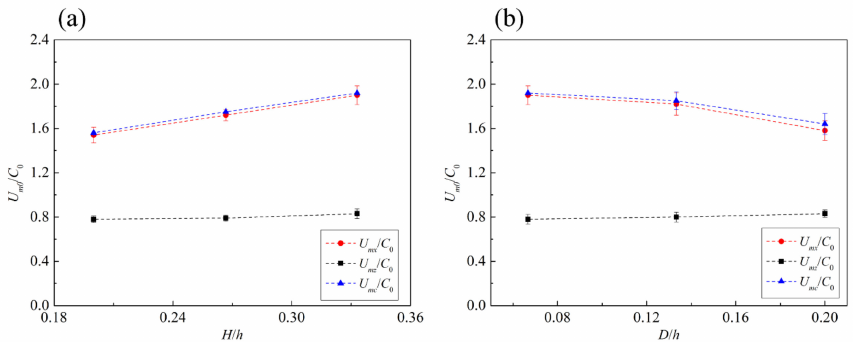
Figure 10. Maximum horizontal velocity, vertical velocity, and velocity magnitude of different cases: ( a ) case 3; case 4, and case 5, D / h = 2/30; and ( b ) case 1, case 2, and case 3, H / h =